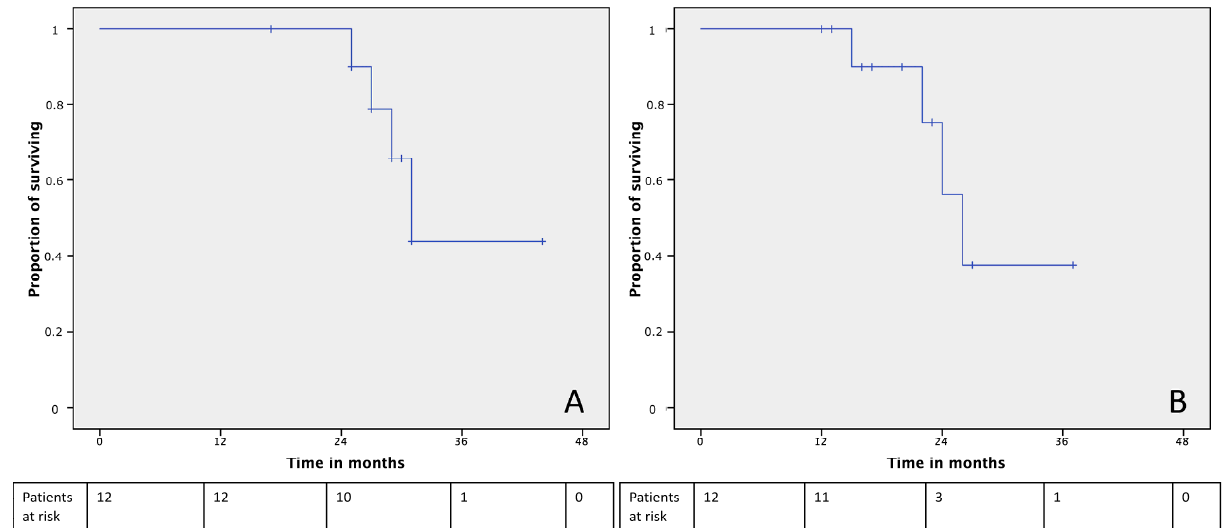
Figure 1. Overall survival curves from the histopathological diagnosis ( A ) and surgery ( B ).